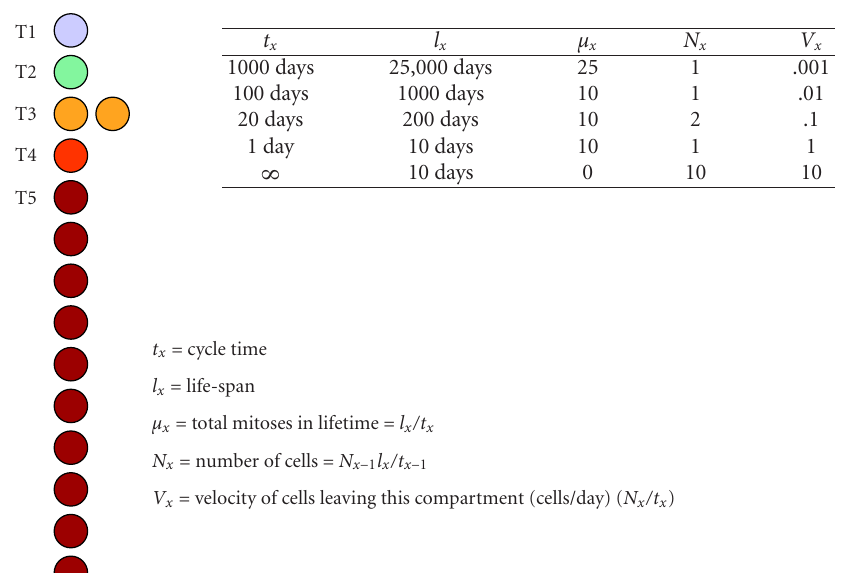
Figure 5. Conceptual model of transit cell amplification. This schematic diagram and associated table illustrate several central con- cepts in the proliferating transit cell paradigm. A stem cell (T1) and three proliferating transit cell populations (T2, T3, and T4) are modeled at steady state in a contiguous linear array supporting a population of mature cells (M/T5). All cell division is modeled as asymmetric events associated with renewal of the founding cell. The table illustrates hypothetical values for the cycle time ( t x ), life- span for cells in each compartment ( l x ), the e ff ective mean number of cell divisions in each compartment ( µ x ), the resulting number of cells resident in each transit compartment ( N x ), and a velocity or rate at which cells leave each compartment ( V x ). In this model, the originating stem cell survives throughout the life of the individual ( l 1 = 25,000 days ∼ 68 years), cycling as a slow rate of one cell division every 1000 days ( t 1 = 1000 days). During the life of the stem cell, it divides a total of 25 times ( µ 1 = 25). The velocity of cells leaving the stem cell compartment and entering the T2 compartment is 1 cell per 1000 days, or V 1 = 0 . 001 cells/day. Cells in the T2 compartment function similarly to feed the T3 compartment, and so on. Cells in downstream populations (T2, T3, and T4) divide more rapidly than cells in upstream compartments. In contrast to the originating stem cells, the cells in downstream compartments also have limited self-renewal capacity, resulting in decreasing functional life-span for cells in each compartment. Note that, in the absence of any transit populations, the upstream stem cell would need to divide 25,000 times to generate the same number of mature cells over the life of the